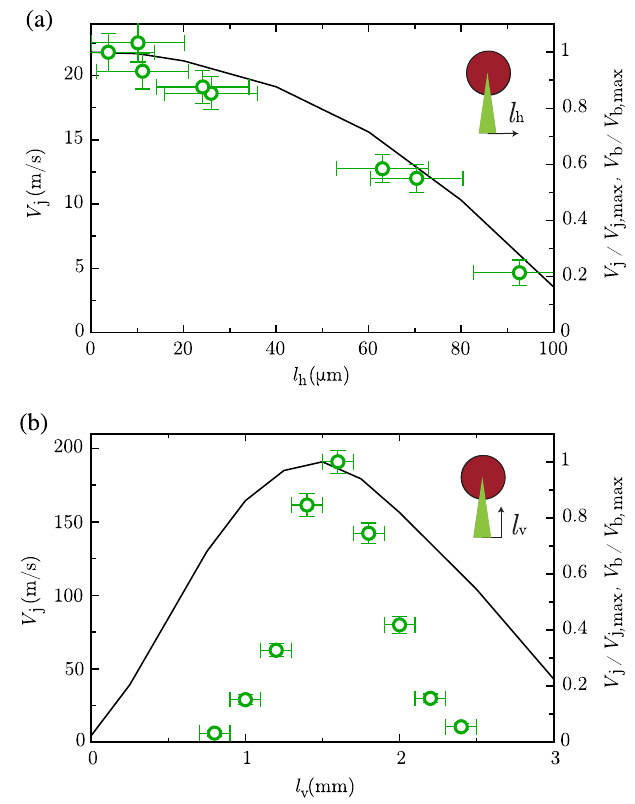
FIG. 9. Prefactor f ð D Þ from Eq. (7) vs the capillary diameter. The circles, squares, and diamonds are constants obtained from the energy-dependence, distance-dependence, and initial-contact angle-dependence experiments, respectively. The value of the prefactor increases with smaller capillaries. A best-fit power law (dashed line) with power (cid:3) 1 : 14 is shown as well as a solid line with power (cid:3) 1 as shown in Eq. (8), which shows less agreement with the data, particularly for small D .